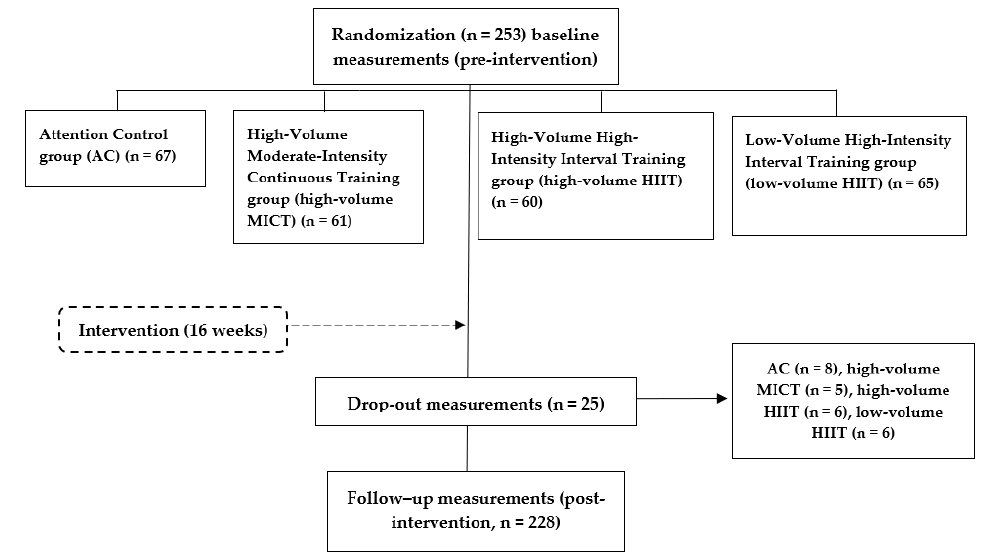
Figure 1. Flow diagram of the EXERDIET-HTA study from recruitment to the follow-up measurements post